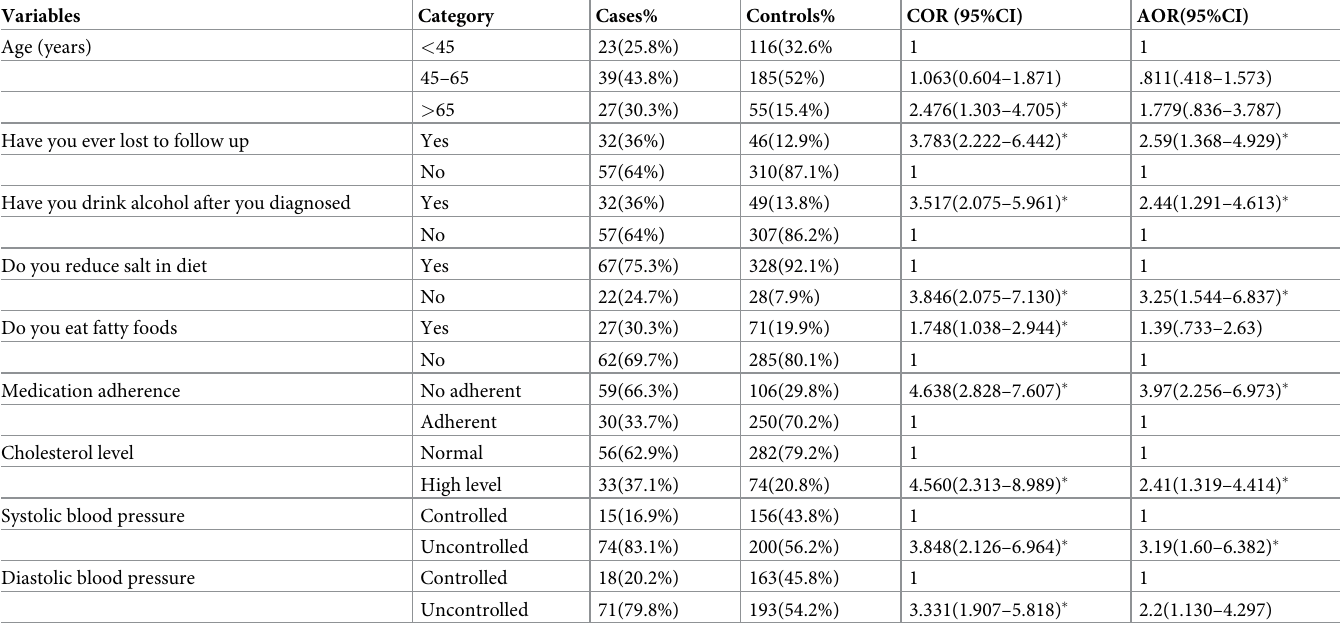
Table 4. Bivariate and multivariable logistic regression result of the